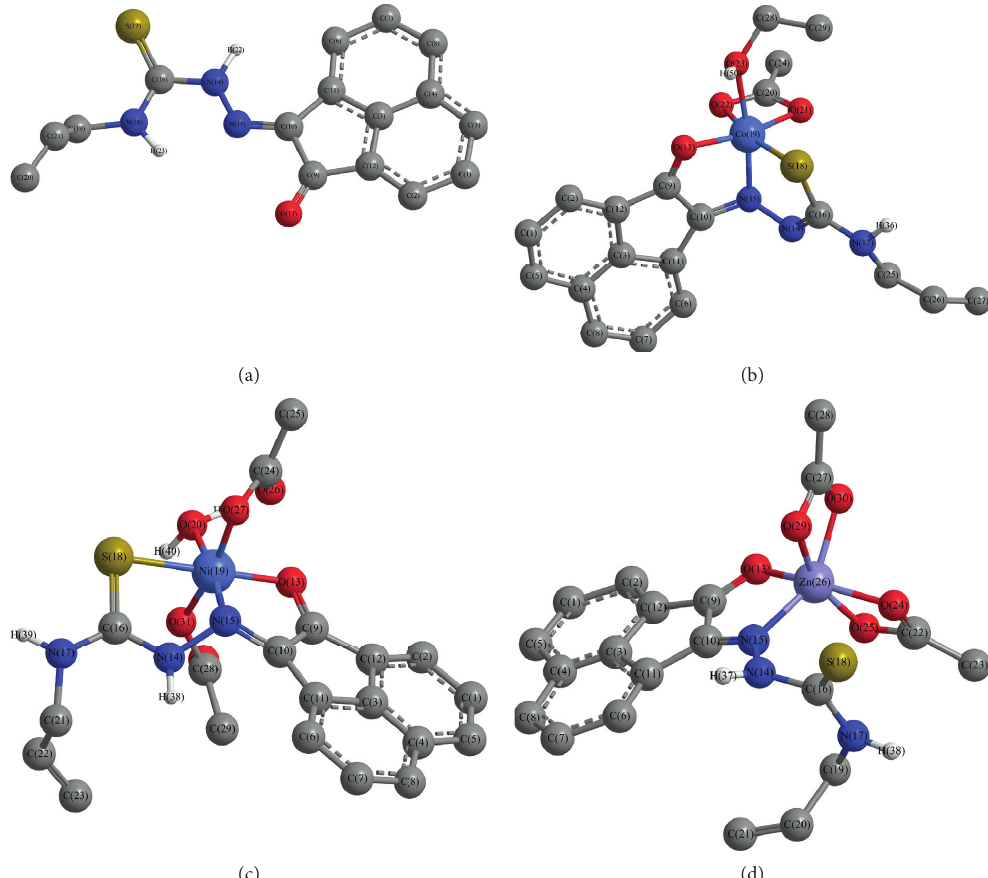
Figure 9: DFT optimized structures of HAAT (a) and Co(II) (b), Ni(II) (c), and Zn(II) (d)